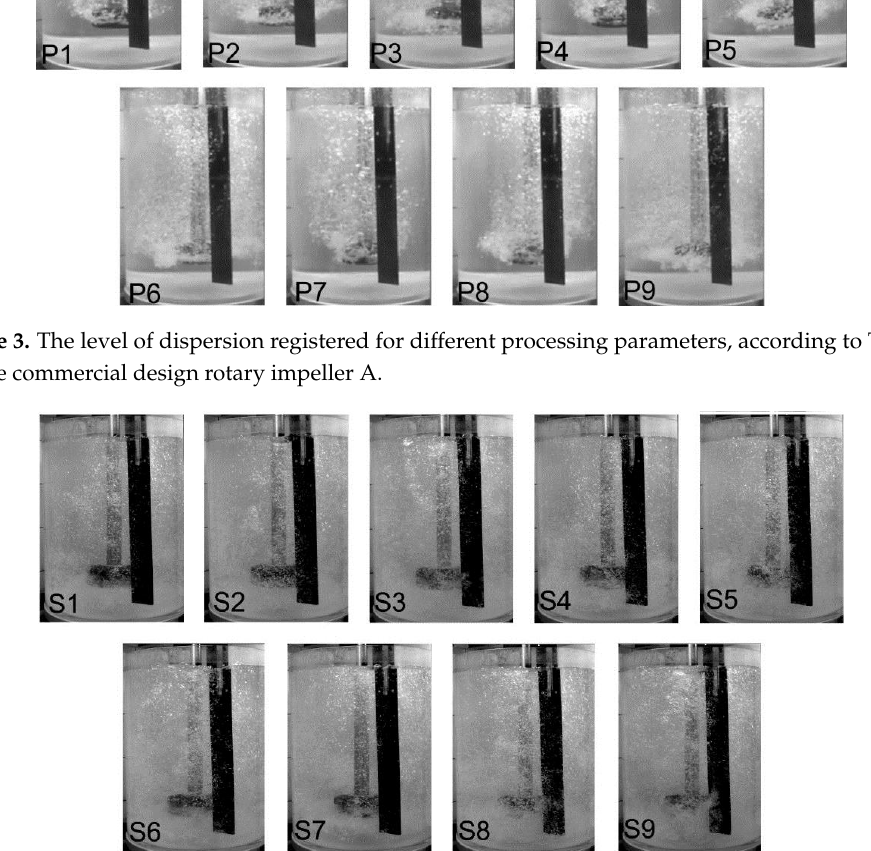
Figure 4. The level of dispersion registered for different processing parameters, according to Table 2, for the new design rotary impeller B.